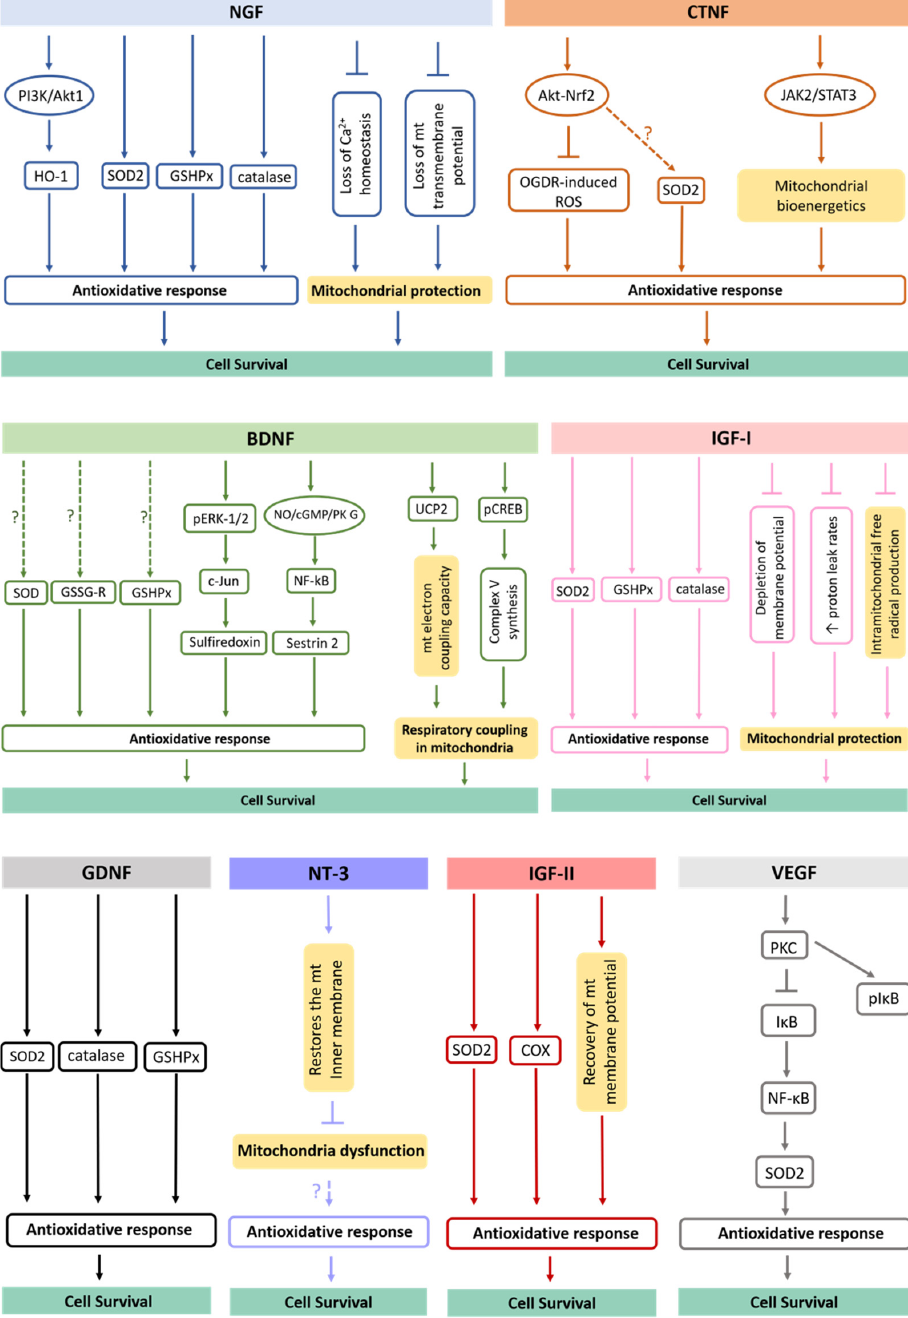
Figure 2. Antioxidative mechanisms triggered by secreted neurotrophic factors. It has been shown that neurotrophic factors act in major antioxidant defense pathways, rescuing target cells from oxidative damage. The underlying mechanisms of this process involve upregulation of antioxidative proteins/enzymes, increase of their activation levels, alteration in Ca 2+ homeostasis, activation of signaling pathways, changes in mitochondrial morphology and dynamics, among others. mt., mitochondria.